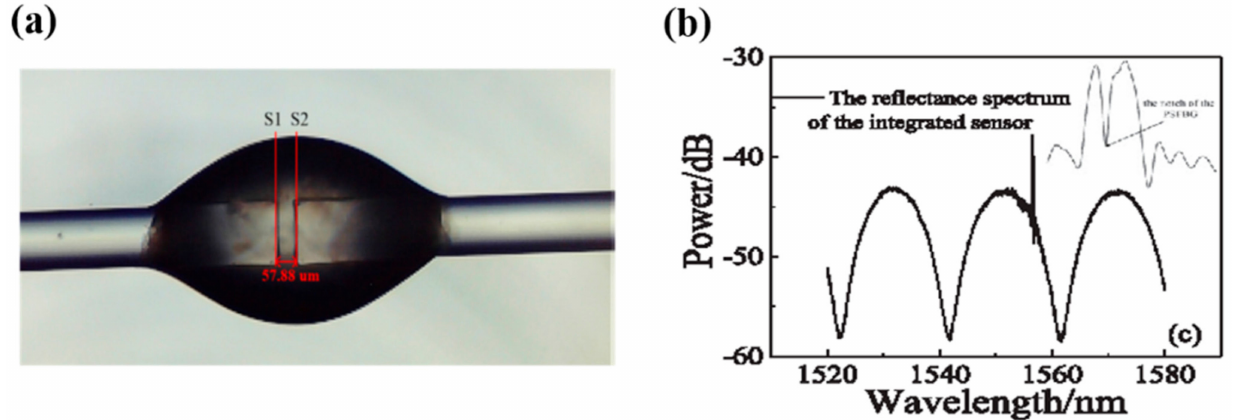
Figure 13. ( a ) Schematic diagram and ( b ) reflectance spectrum of the FBG-FP-based sensor for simultaneous measurement of three-parameter. Adapted with permission from ref.